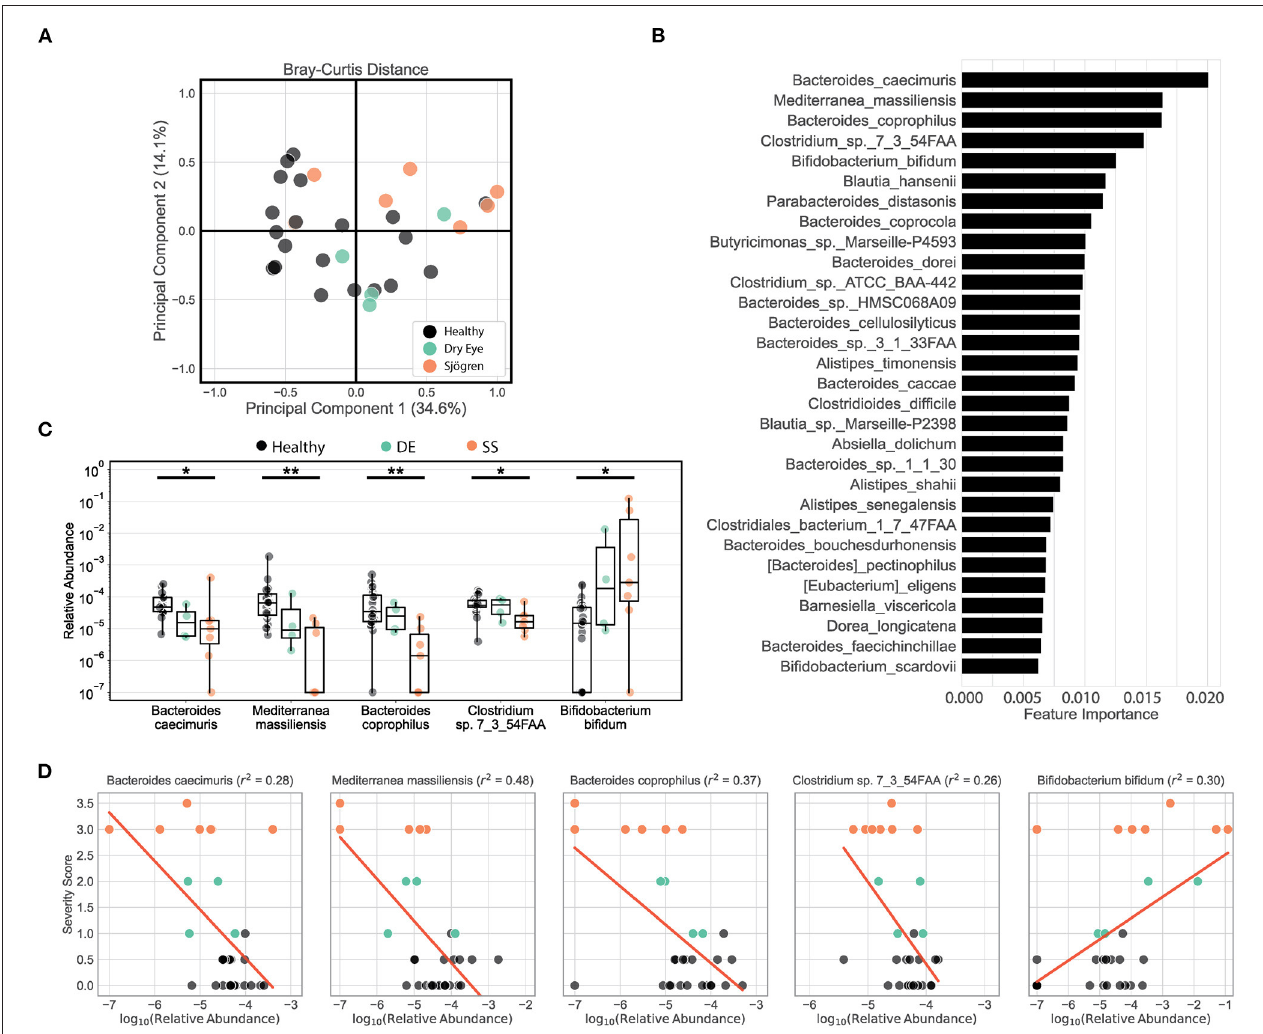
FIGURE 2 | Metagenomic sequencing of SS patient stool shows decreased diversity and identifies differential bacterial species that correlate with disease severity. (A) Principal coordinate analysis of the Bray-Curtis distances between healthy, dry eye, and Sjögren syndrome (SS) subjects. (B) Top 25 species ranked based on their relative importance in a Random Forest model trained to separate healthy controls from SS patients. (C) Box plots describe the relative abundance in healthy controls, dry eye patients, and SS patients for the top 5 ranked species selected by the Random Forest model. Box plots show the median, the ranges between the first and the third quantile, and the ranges between the lowest and the highest value. Statistical significance was assessed using non-parametric Mann-Whitney U tests. * P ≤ 0.05, ** P ≤ 0.01. (D) Scatter plots for the correlation between severity scores and log-transformed relative abundances for the top 5 species selected by the Random Forest model. Red lines show the predicted severity scores based on simple linear regression models. The goodness of fit is estimated by the coefficient of determination r 2 shown in the title texts. For ease of visualization in scatter and box plots, a pseudocount of 10 − 7 was added to all relative